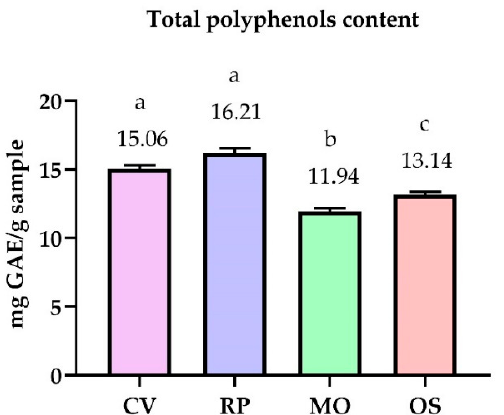
Figure 1. Content of total polyphenols in the studied samples. Mean values are expressed as mg gallic acid equivalent GAE/g sample. The error bars indicate standard deviation. Different letters among samples indicate significant differences ( p < 0.05) among values according to the t -test. Table 2. The individual profile of polyphenols detected using the LC method (mg · g − 1 ).